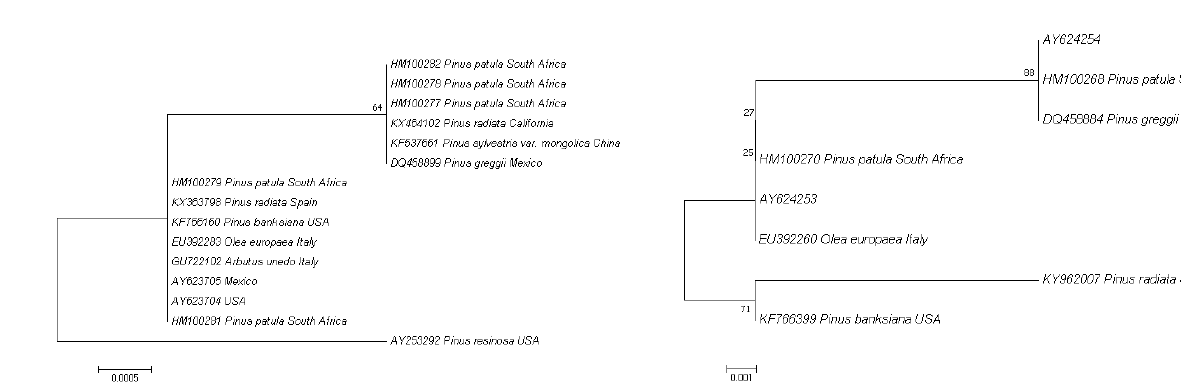
Figure 2. Dendrogram obtained from the dataset of 15 Di- plodia scrobiculata isolates using the ITS region. Branches are labelled with the bootstrap values. Unlabelled branch- es have bootstrap values less than 50%.